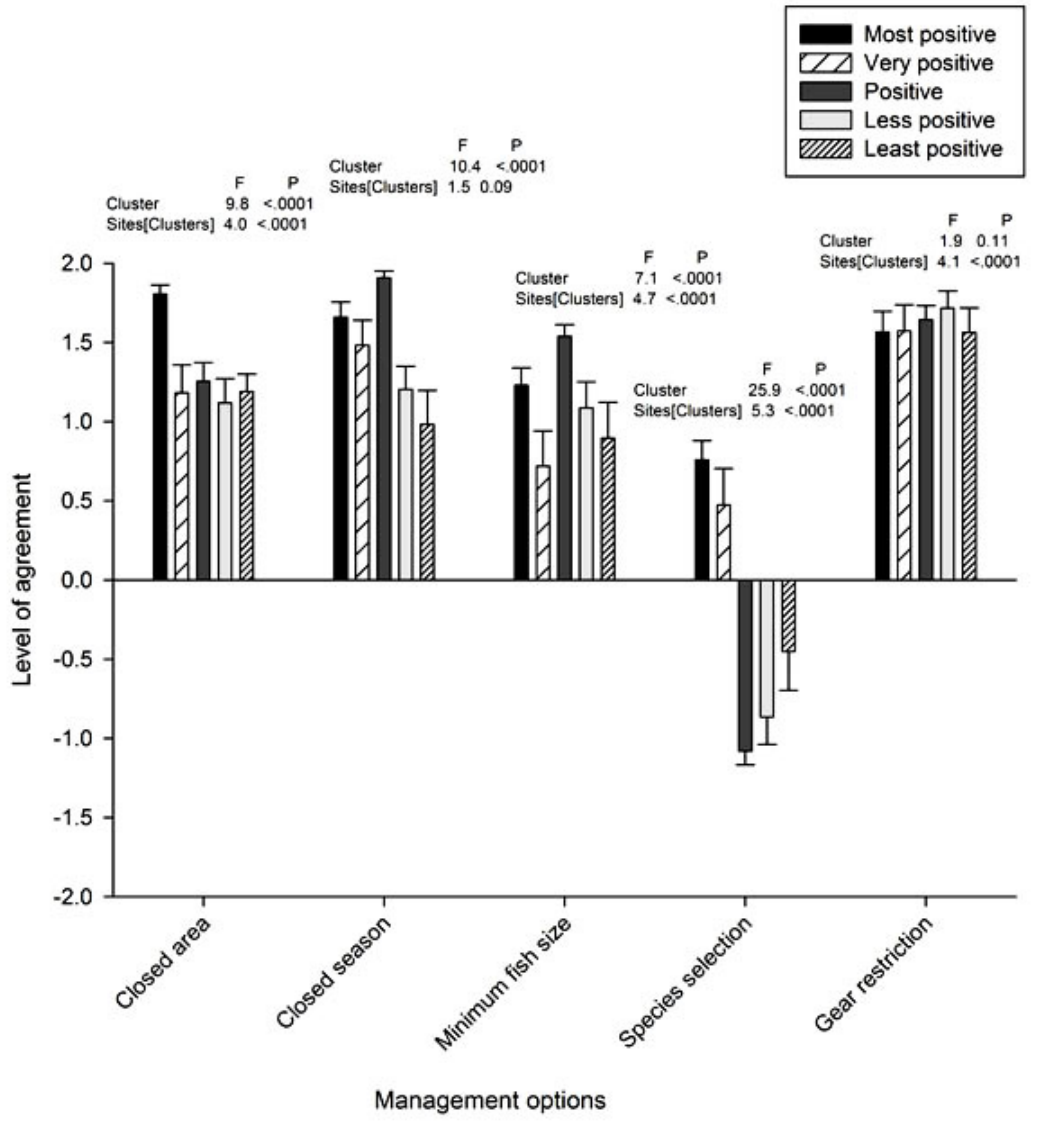
Fig. 3. Fishers’ ratings (mean ± SE) of the perceived sustainability of five proposed management restrictions analyzed for five village clusters, based on fishers’ perceived personal benefits from the restriction. Results of nested ANOVA for tests of differences between clusters and nested villages are given for each